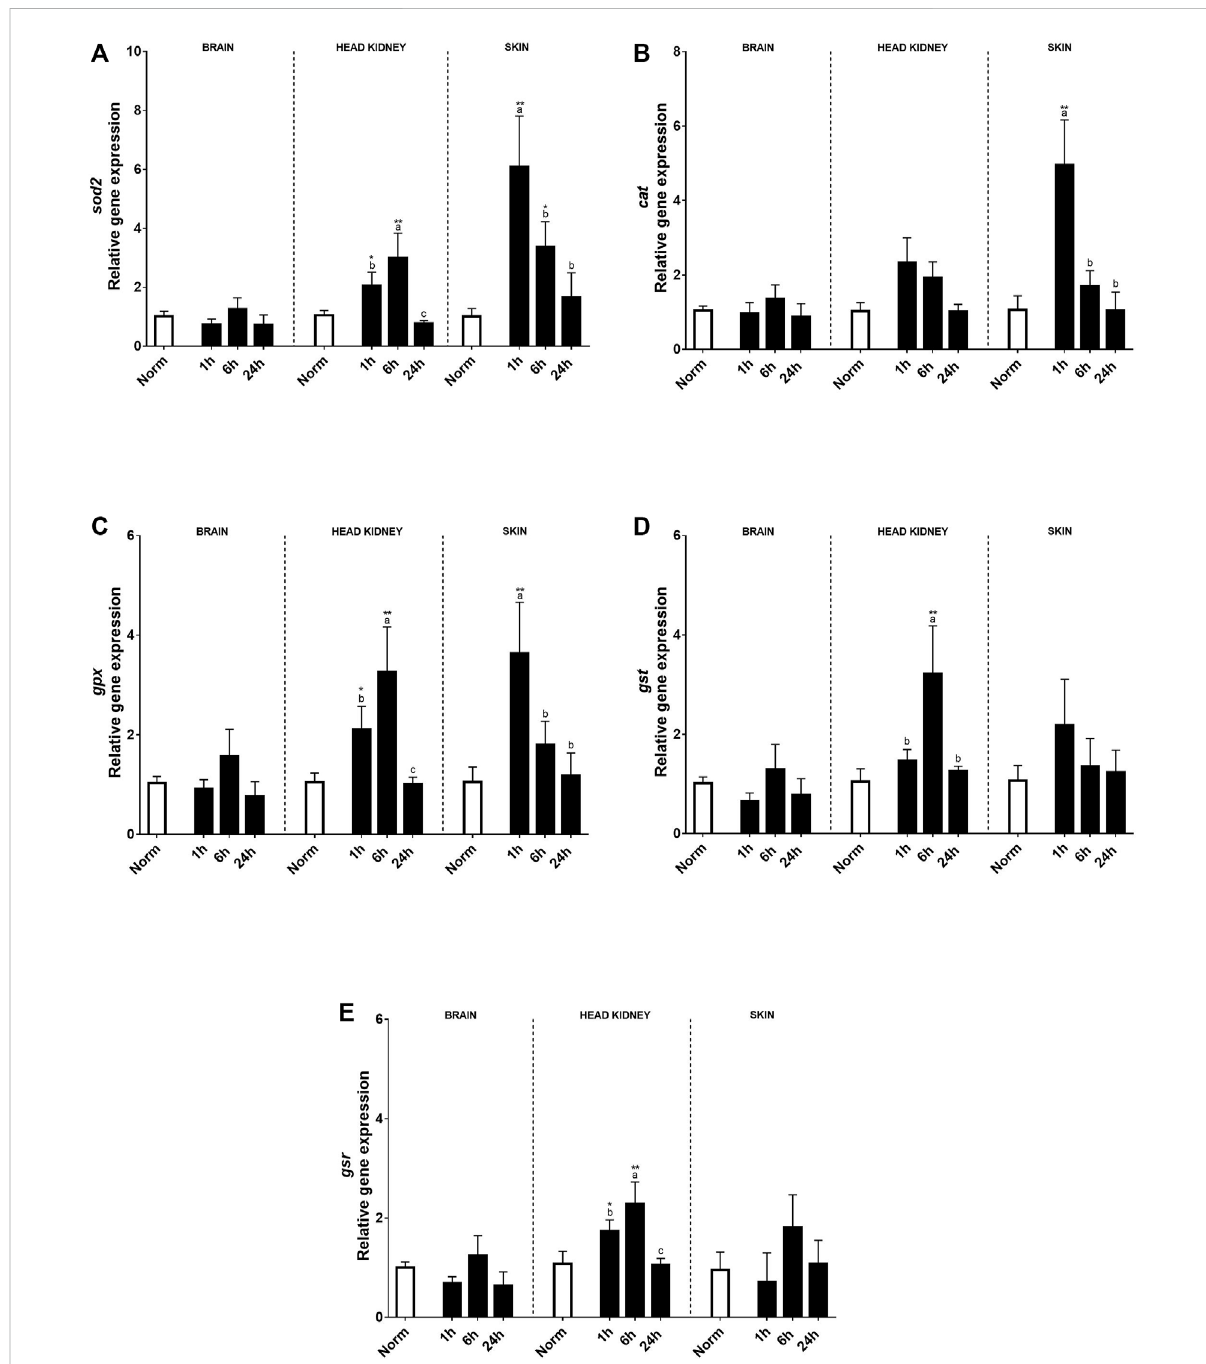
FIGURE 5 Transcript levels of antioxidants (A) sod2 , (B) cat , (C) gpx , (D) gst , and (E) gsr in rainbow trout brain, head kidney, and skin after normoxia and acute hypoxia with different recovery times (1, 6, and 24 h). The values are presented as mean +SEM ( n = 8). Signi fi cant differences between time points after hypoxia are shown by letters; between hypoxia treated and normoxia are shown by * ( p < 0.05) or ** ( p <